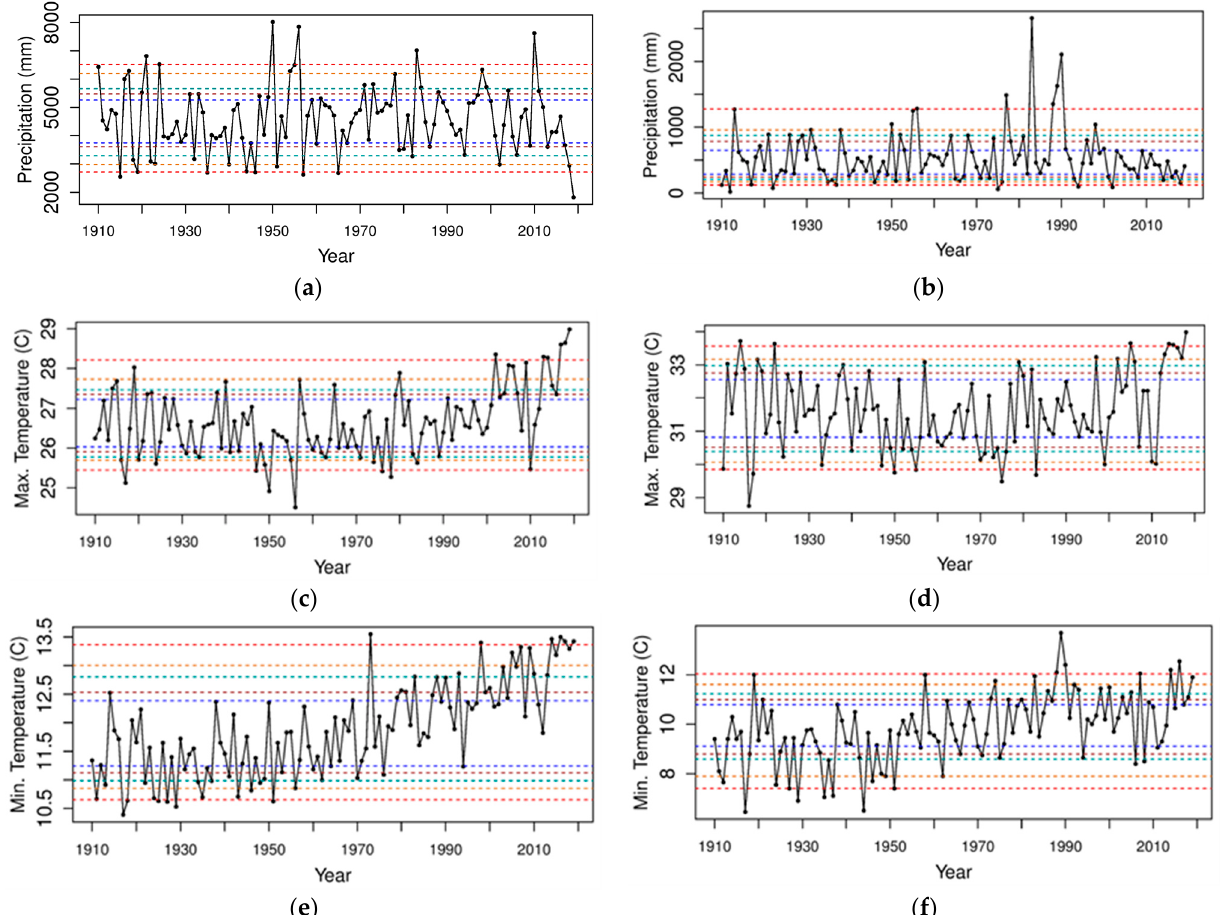
Figure 4. Precipitation, TMax and TMin time series in the NMDB . Precipitation time series in the NMDB for, ( a ) annual, ( b ) April–May. Dashed lines indicate percentiles 5th and 95th (red); 10th and 90th (orange); 15th and 85th (light blue); 20th and 80th (brown); and 25th and 75th (dark blue). Note the apparent decrease in mean and reduction in values greater than the 75th percentile for April–May since the 1990s and the decrease from 2011 to well below the 5th percentile in 2019 for the annual time series; the time series of TMax in the NMDB for, ( c ) annual, ( d ) October–March. Note the steep increase approaching the 100th percentile in both October–March and annual time series which mirrors the steep decrease in 2019 annual precipitation (Figure 4b); the time series of TMin in the NMDB for, ( e ) annual, ( f ) April–May. Note the almost linear increase in the annual times series since the 1960s and the step increase with much less variation since 2014, while there is no clear trend in April–May apart from one step increase after the 1950s and another from 2014.